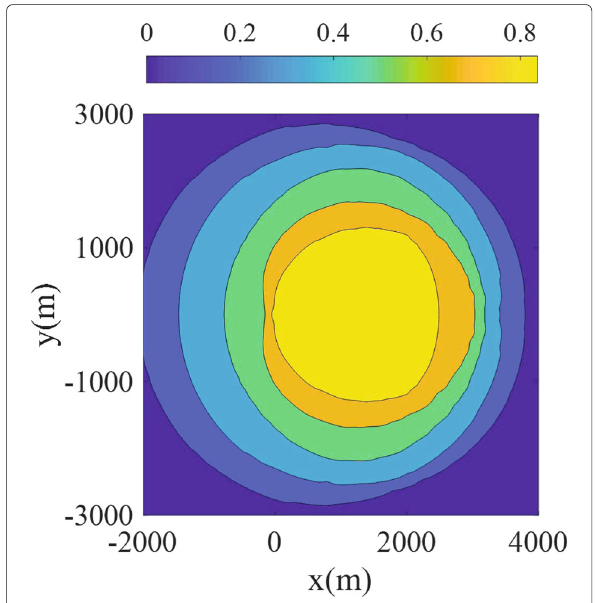
Fig. 5 The maximum achievable eavesdropping rate versus the position of E for DF relaying